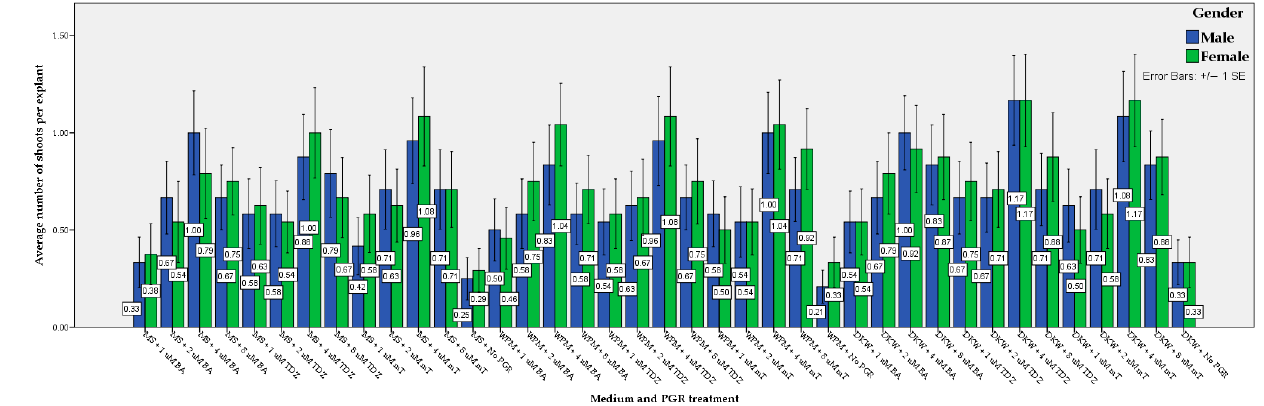
Figure 2. Effect of the medium and plant growth regulator types and their concentrations on the average shoot number per Juniperus drupacea explant in relation to their gender.